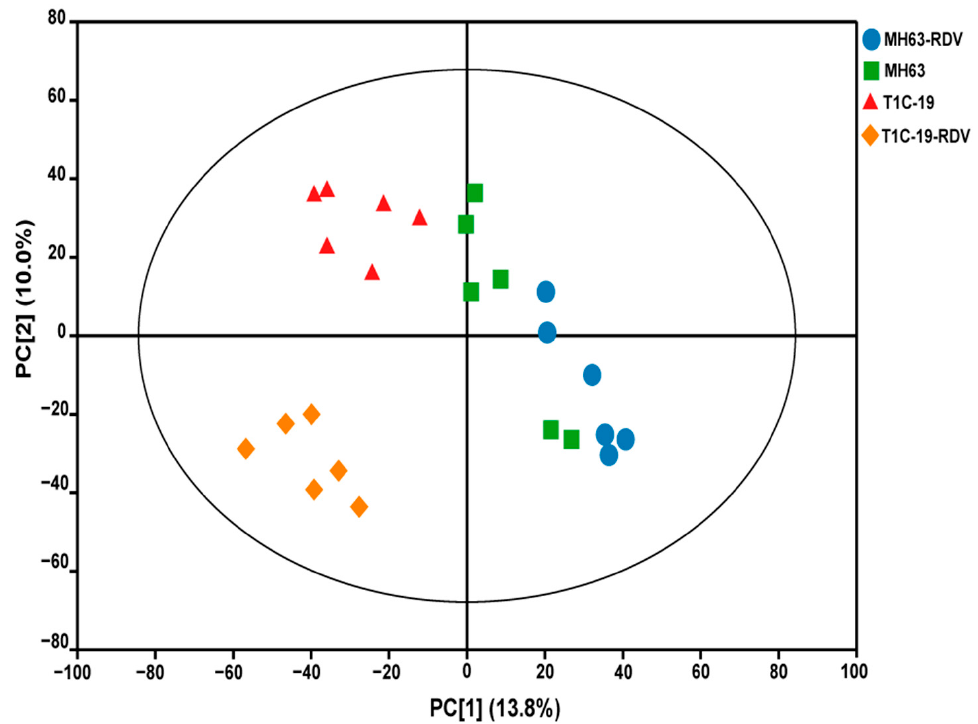
Figure 1. Principal component analysis (PCA) score plots of the 320 identified metabolites in rice leaves of the four treatments. MH63, green square; T1C-19, red triangle; MH63-RDV, blue circle; T1C-19-RDV, orange rhombus.